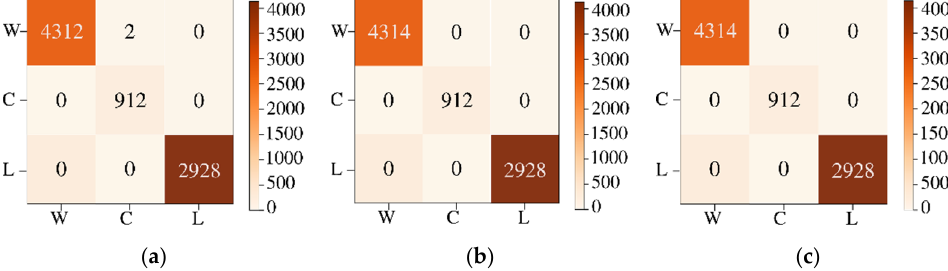
Figure 12. Confusion matrices for classification of HSI2 Image 2 into 3 classes for a batch size of 1500 using 3 PCA bands with the three types of scaling methods ( a ) normalization scaling (ns), ( b ) max- imum scaling (ms), ( c ) scaling (sc)).